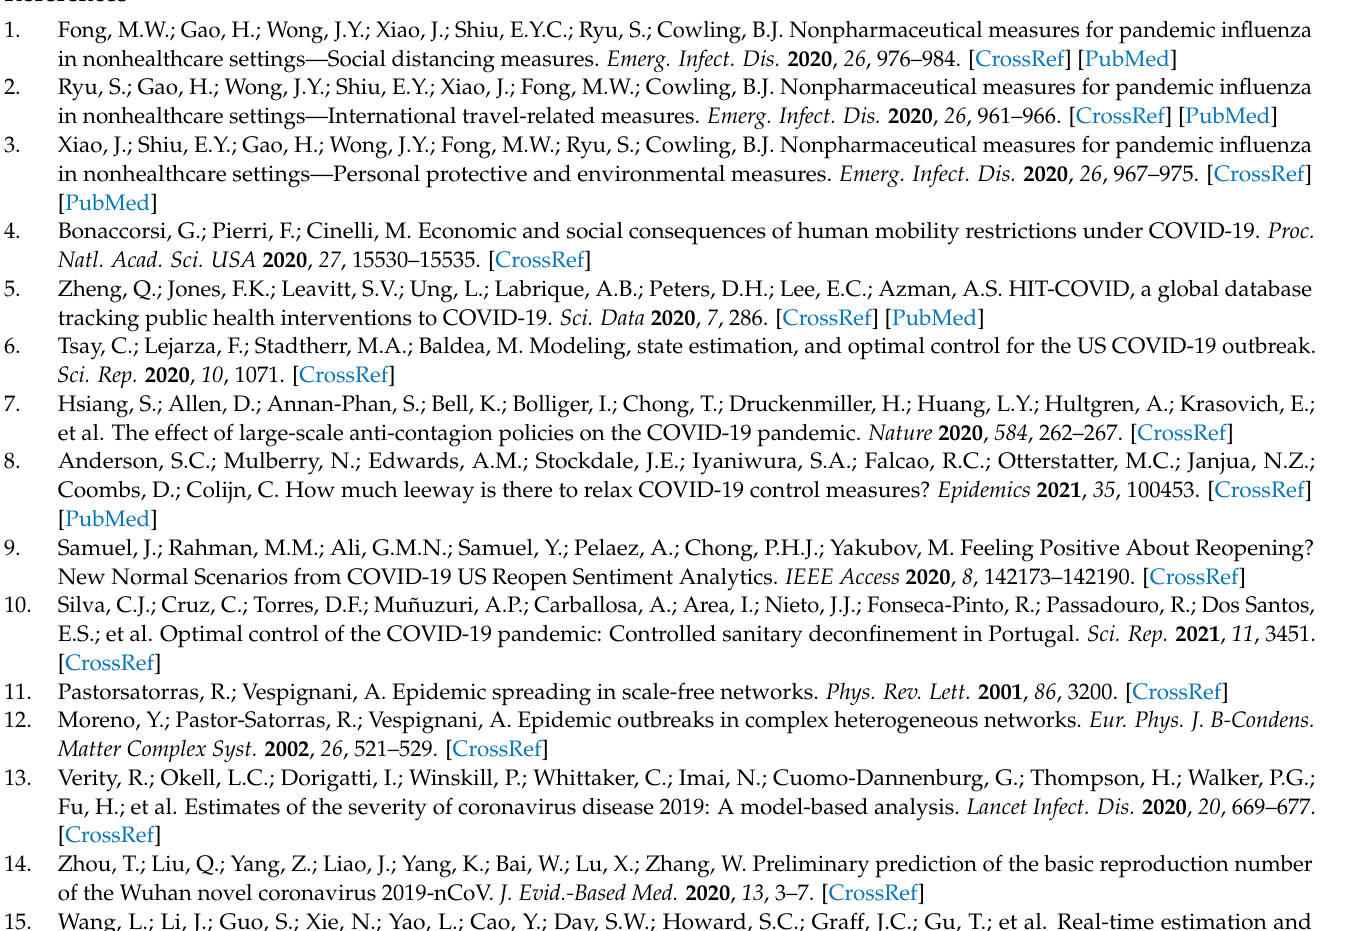
Table S1. The folder “code” contains the source code for the model proposed in the paper. The folder “results of data” contains all the results of running the program. Specifically, it includes all the experimental results: comparing non-pharmaceutical interventions and null model, exploring global and local interventions in terms of intensity and timing, analyzing different initial